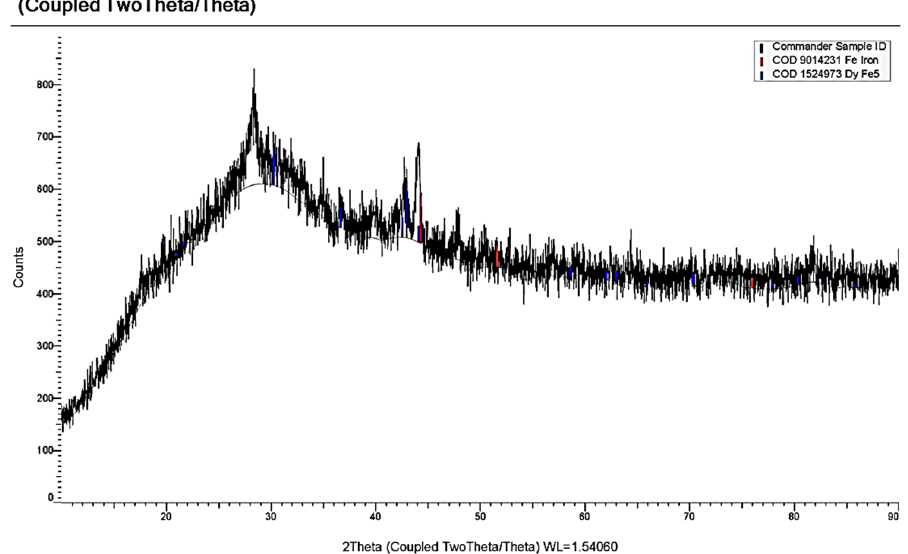
Figure 14. X-ray pattern of the cathode deposit obtained by electrolysis of the KCl-NaCl-DyCl 3 -FeCl 3 melt at 973 K for 1 h and the cell voltage of 2.8 V. Concentration of DyCl 3 is 3.0 × 10 − 4 mol/cm 3 . Concentration of FeCl 3 is 1.5 × 10 − 4 mol/cm 3 . Electrochemical cell voltage = 2.8 V; T = 973 K; t = 1 h.